Question: Summarize what this figure shows in one sentence.
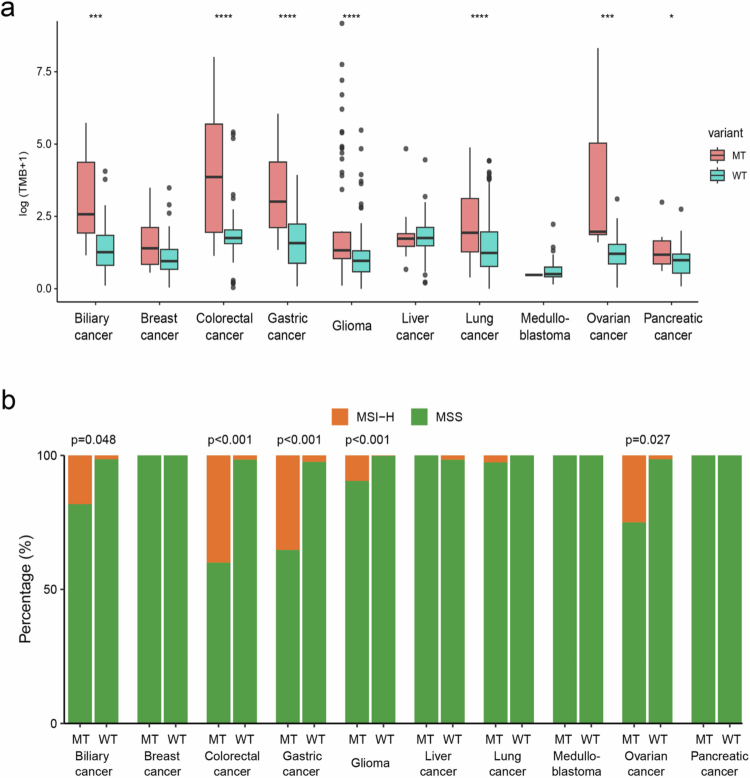
Answer: TMB and MSI status (MSI-H vs. MSS) according to PI4K/PIPK alterations across cancer types. a, Box plots comparing TMB between tumors with mutant (MT) and wild-type (WT) PI4K/PIPK genes across different cancer types. b, Association between PI4K/PIPK gene mutations and MSI status (MSI-H vs. MSS) in specific cancer types, with corresponding p -values from statistical tests.